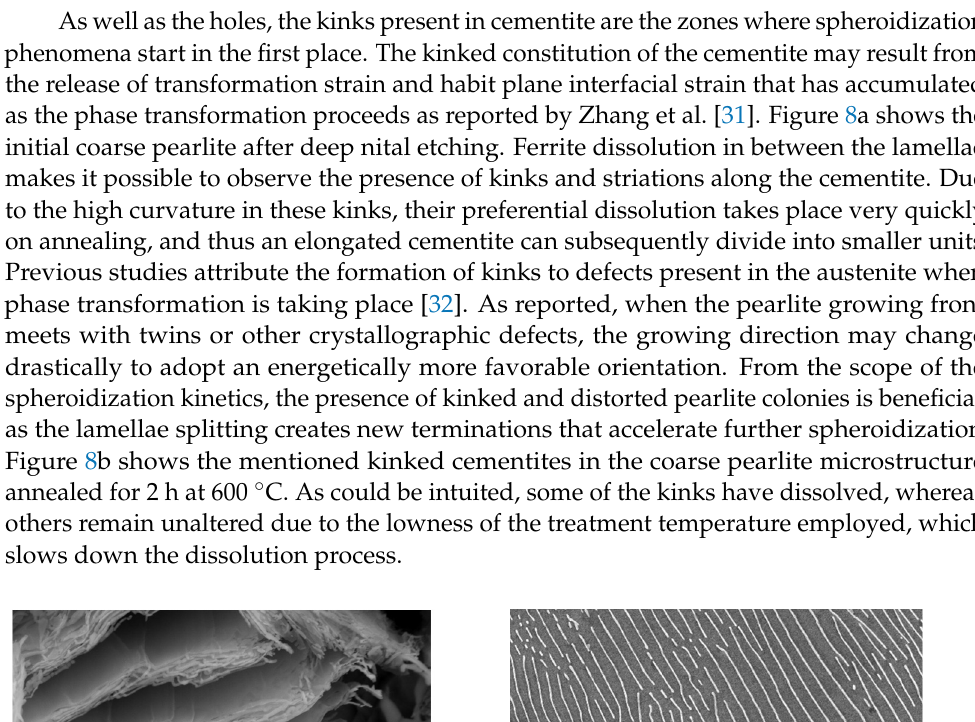
( b ) Figure 9. Cementite edge spheroidization before break-up into globular units ( a ), and detail of the edge spheroidization phenomenon depending on the cementite lamellae aspect ratio ( b ), after the intermediate annealing treatment in the coarse pearlite microstructure. The initial fine pearlite microstructure provides more lamella terminations than the coarse pearlite, where the cementite lamellae are elongated. This difference in termination